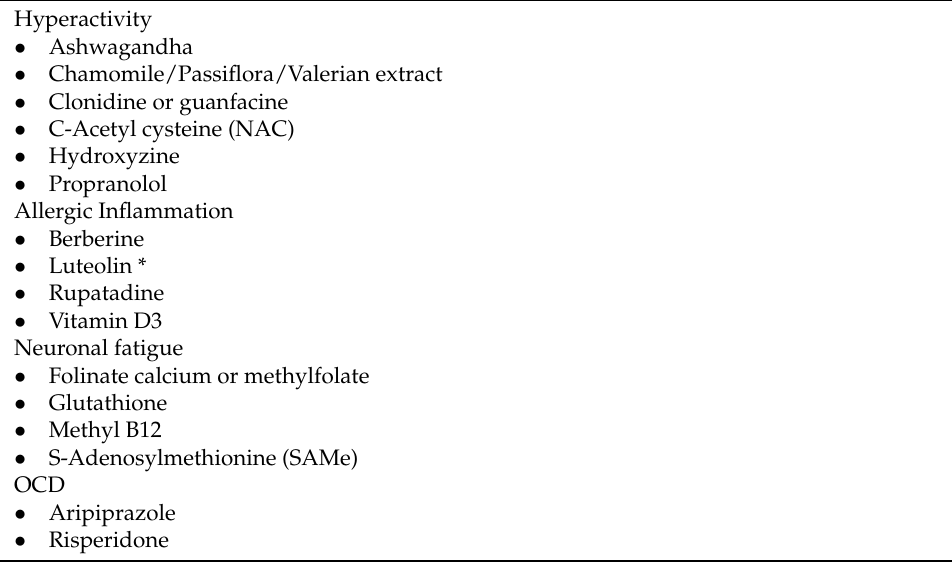
Table 6. Treatment Approaches.